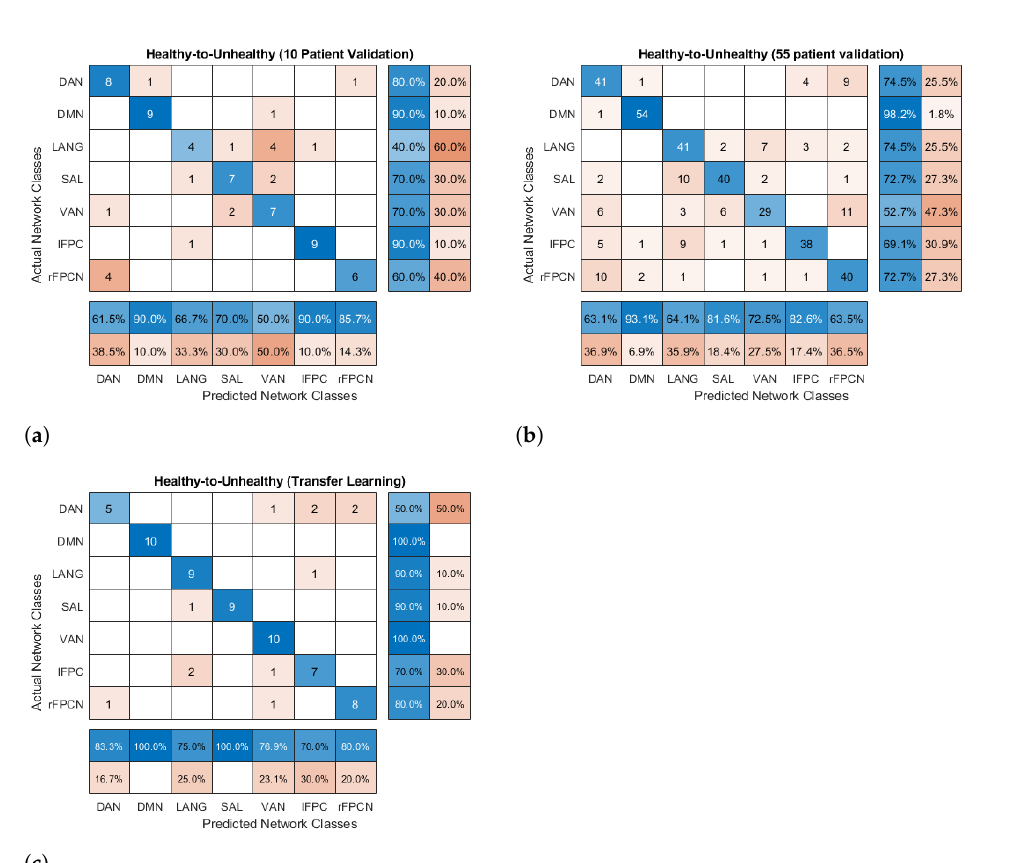
Figure 8. Confusion matrix of functional network prediction by proposed CNN model on all indi- vidual functional brain networks as classes LANG, SAL, VAN, DMN, lFPCN, rFPCN, and DAN. ( a ) Confusion matrix of brute transfer learning from healthy to unhealthy data. ( b ) Confusion matrix of brute training on healthy and validation with all unhealthy data. ( c ) Confusion matrix of weight transfer learning from healthy to unhealthy